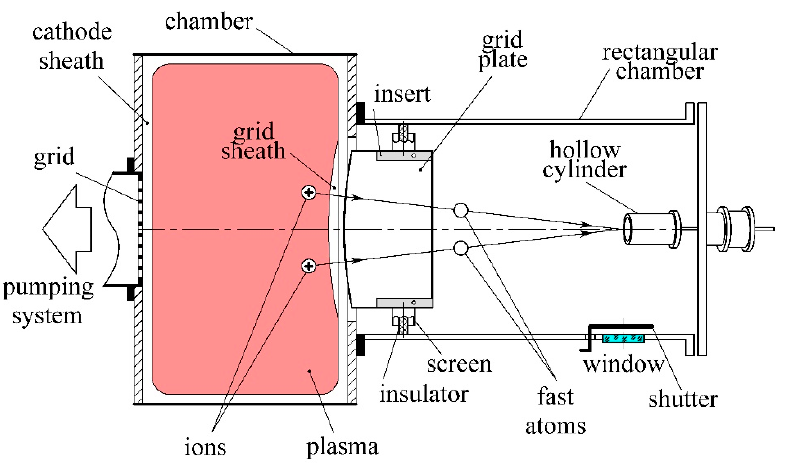
Figure 2. Schematic of experimental setup for the combined processing (top view). At the top of the rectangular chamber, a magnetron [13,14] with 10-cm-diameter round target and a high-voltage feedthrough are mounted. The feedthrough allows to connect the grid to an accelerating voltage power supply and regulate the negative voltage from zero to 5 kV. The positive pole of the glow discharge power supply can be connected by means of a switch to either an anode inside a rectangular chamber or a second anode inside a cylindrical chamber. The working gas (argon) is fed into a rectangular chamber and pumped out by rotary and turbomolecular pumps to a residual gas pressure of 0.001 Pa through a flat grounded grid on the left wall of the cylindrical chamber. The gas pressure in the chamber is measured by a Baratron gauge and adjusted from the control panel. The gas discharge power